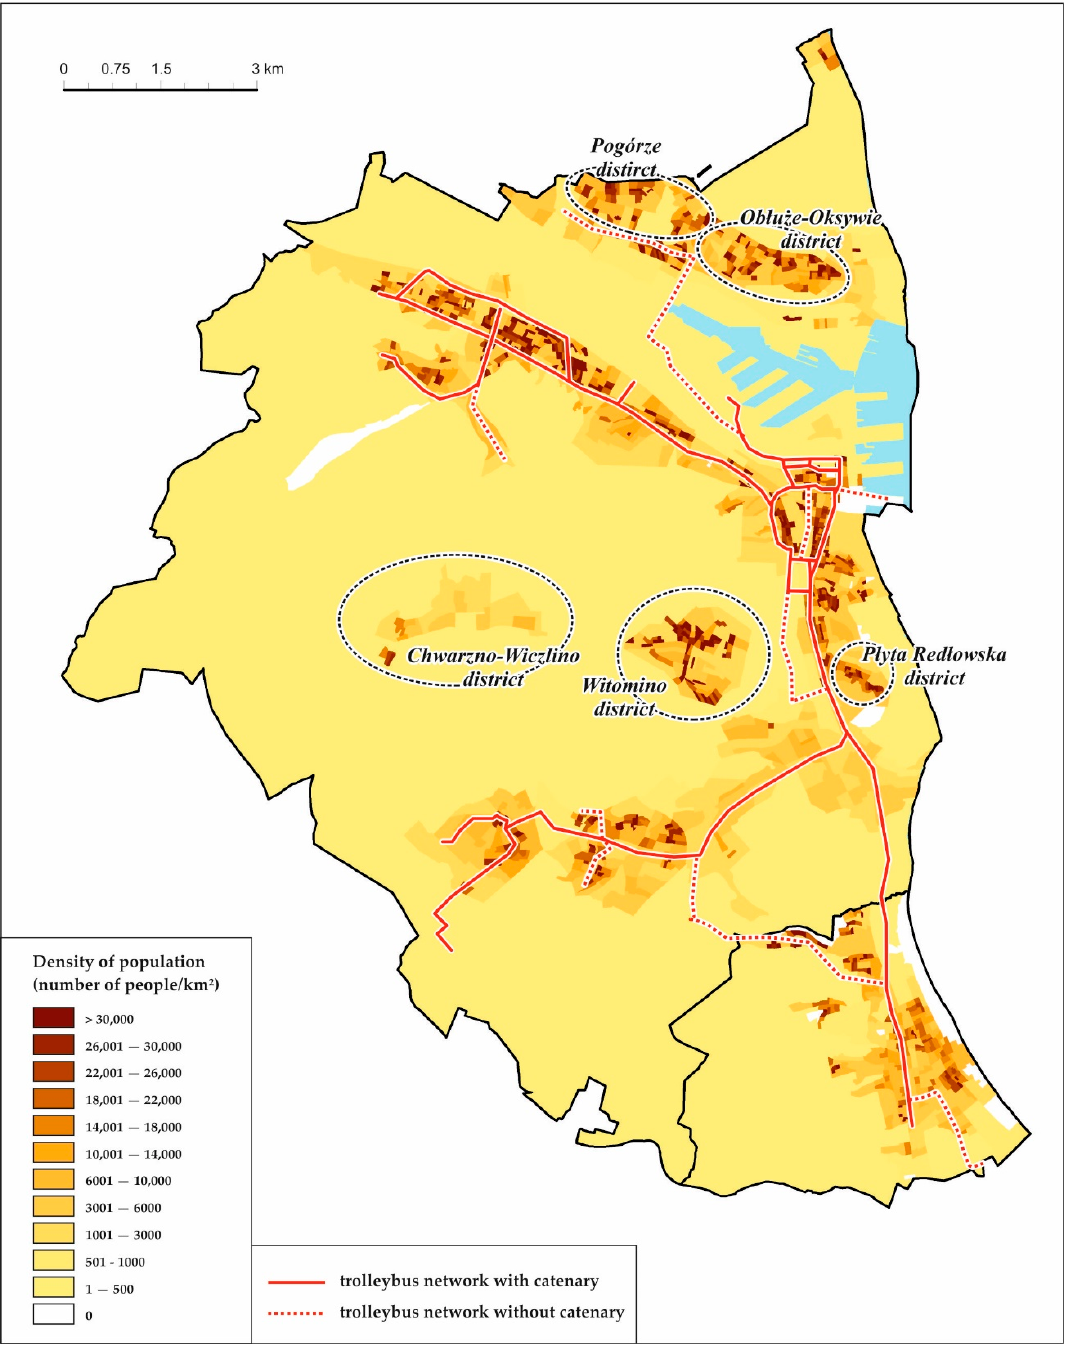
Figure 6. The public transport network in Gdynia in the context of the population density (source: own elaboration).